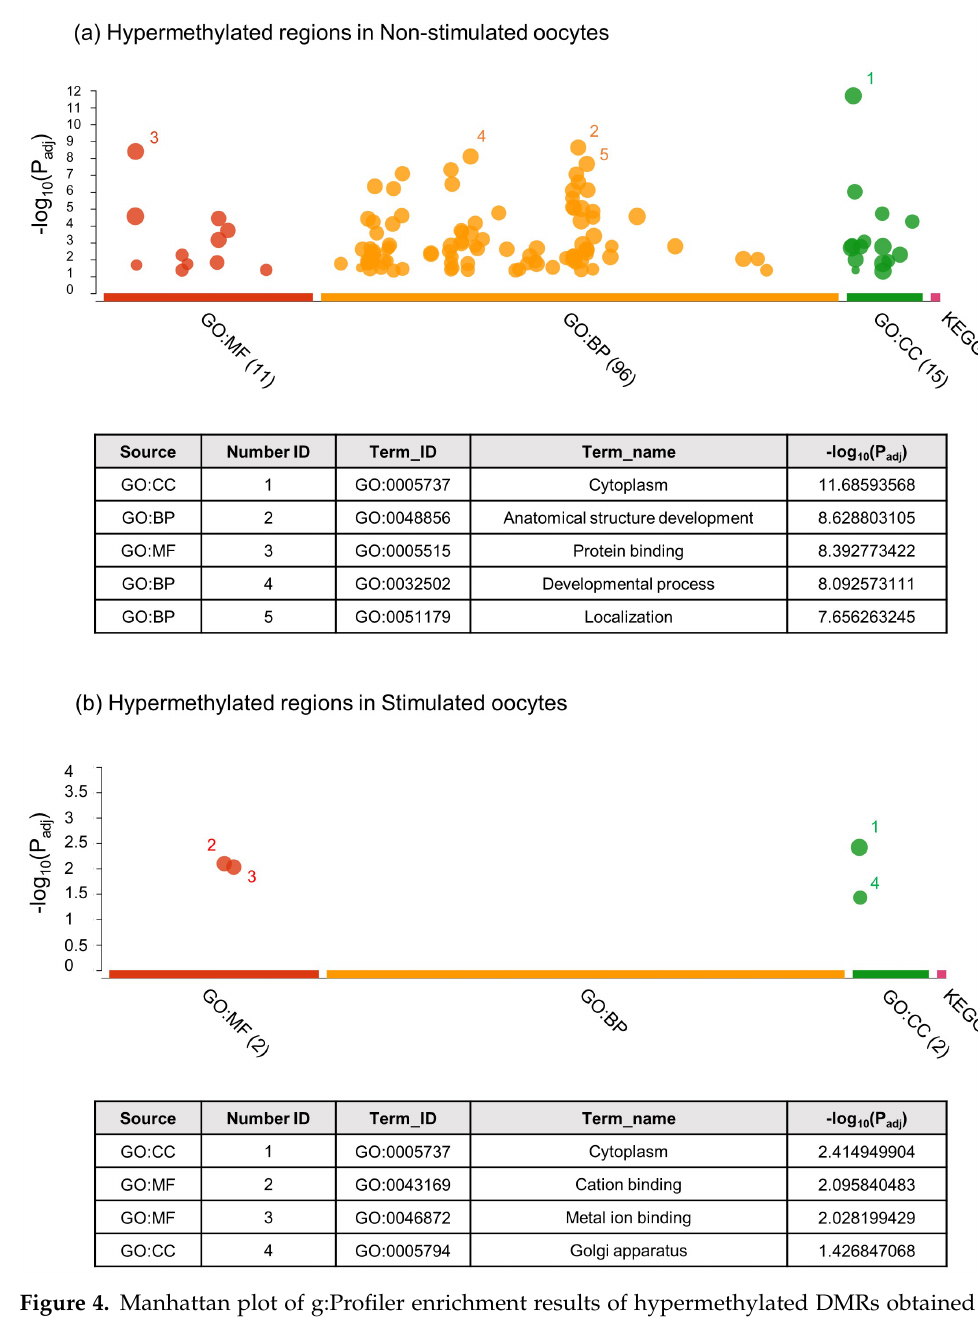
Figure 4. Manhattan plot of g:Profiler enrichment results of hypermethylated DMRs obtained in non-stimulated ( a ) and stimulated oocytes ( b ). GO (Molecular Function – MF, red colour; Biological Process – BP, orange colour; and Cellular Component – CC, green colour) and KEGG database (pink colour) were used for the analysis. Only terms with a p value < 0.05 are shown. The table below shows the top five enriched representative terms, and the statistical value for each term is indicated by the −Log10 ( p value).